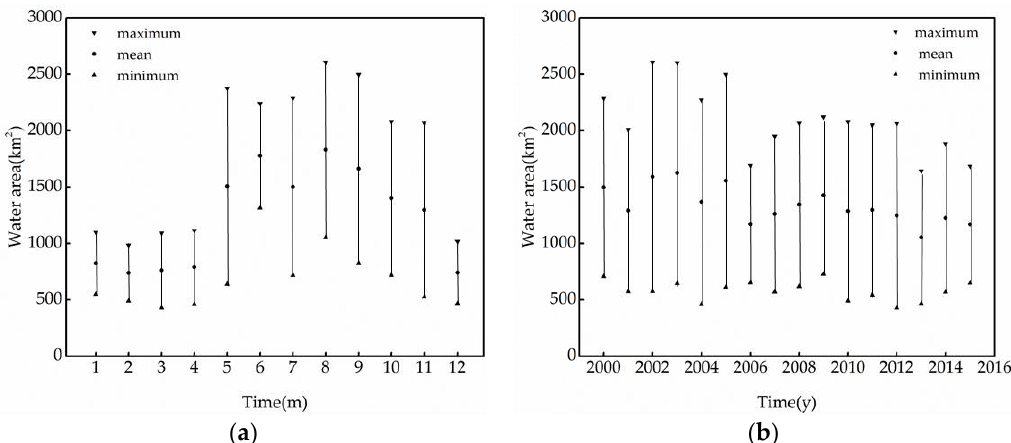
Figure 3. Trends in the maximum and minimum water area from 2000 to 2015. ( a ) Monthly changes and ( b ) annual changes.